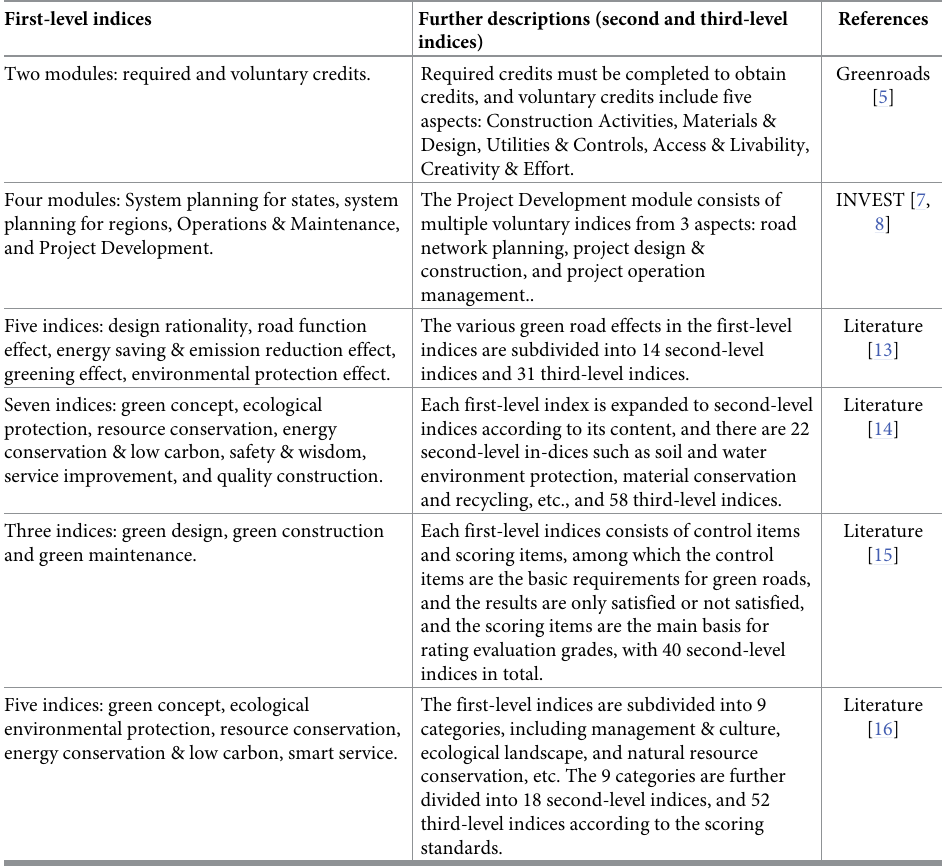
Table 1. Specific indices of different index systems in some of the